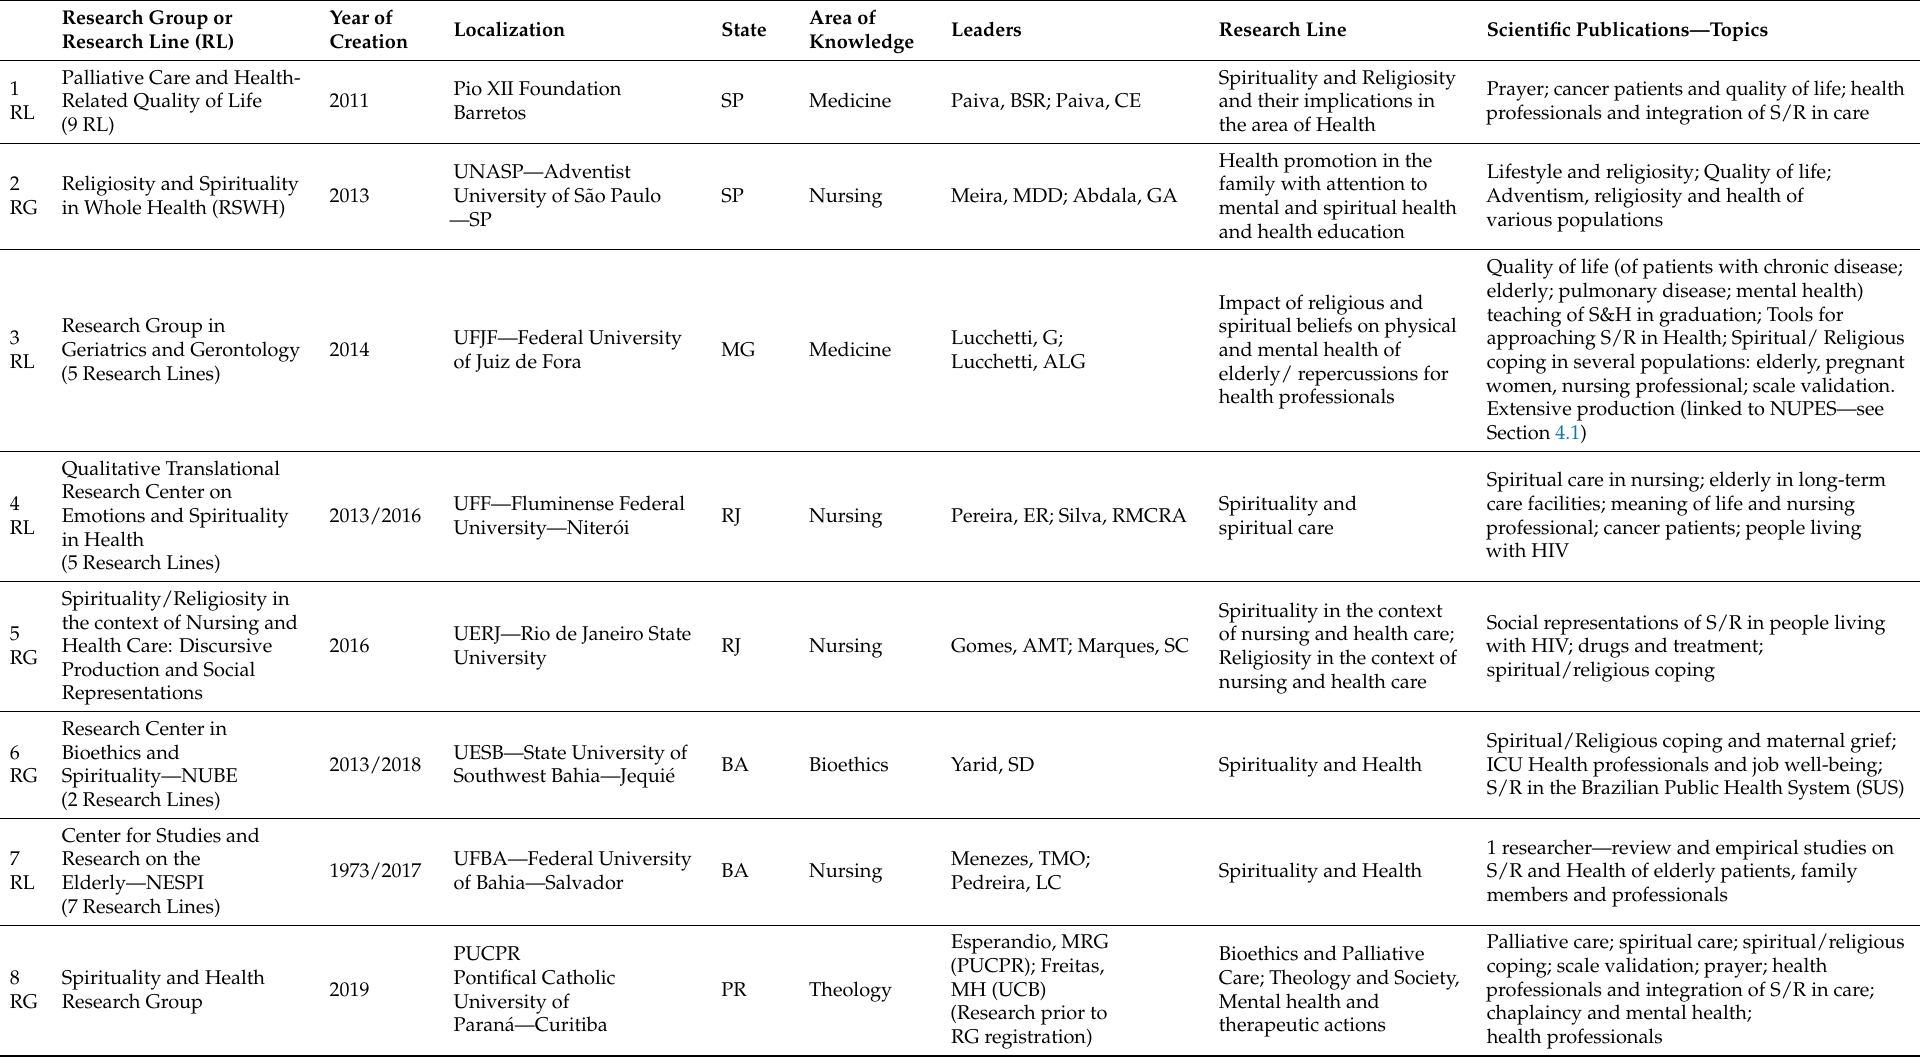
Table 2. Established research groups with main focus on Spirituality and Health (RG) or research lines (RL) on Spirituality and